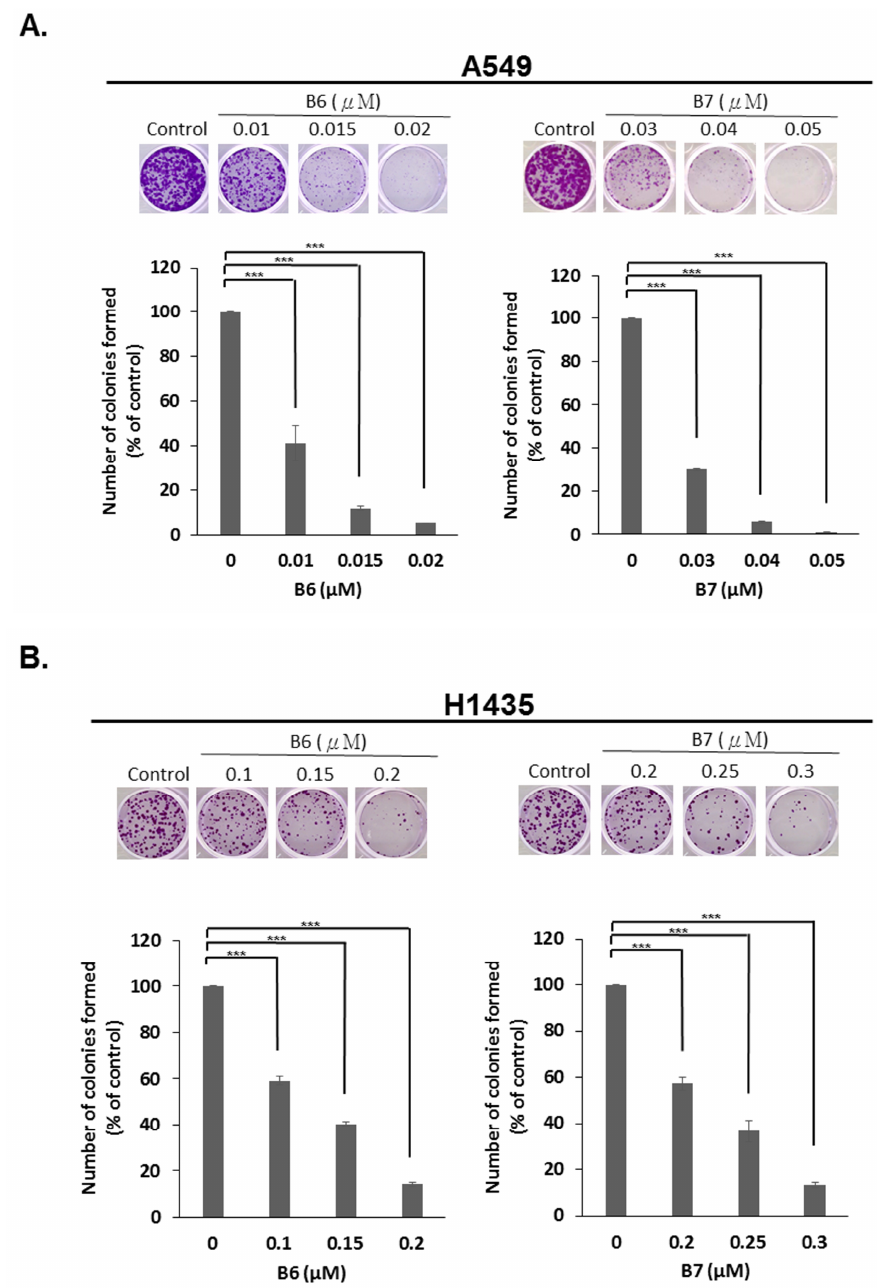
Figure 5. Suppression of in-vitro tumorigenesis in non-small-cell lung cancer cells with B6 and B7. ( A ) A549 and ( B ) H1435 cells were treated with control medium or B6 and B7, and the colonies formation assay was used to evaluate the modulation of in-vitro tumorigenesis ability. GAPDH was used as a loading control. Five independent experiments were conducted. *** means p < 0.001.